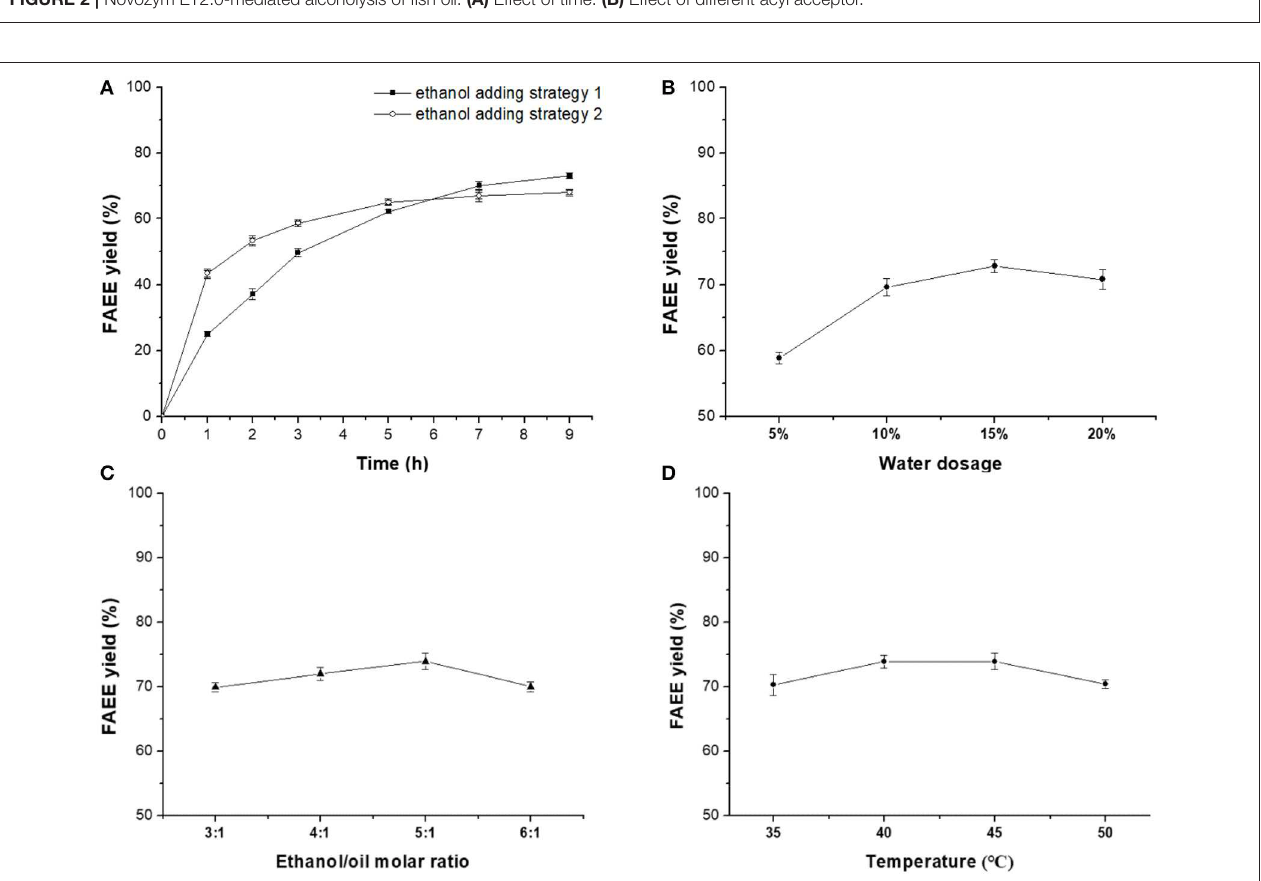
FIGURE 3 | Optimization on Novozym ET2.0-mediated ethanolysis of fish oil. (A) Effect of time. (B) Effect of water dosage. (C) Effect of ethanol/oil molar ratio. (D) Effect of